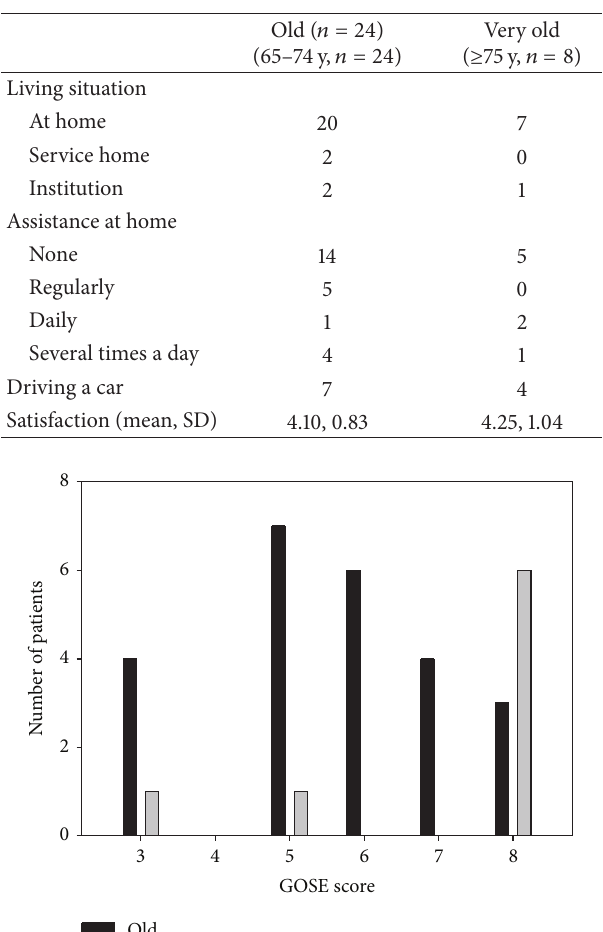
Table 3: Characteristics of the surviving old and very old patients at one-year follow-up.